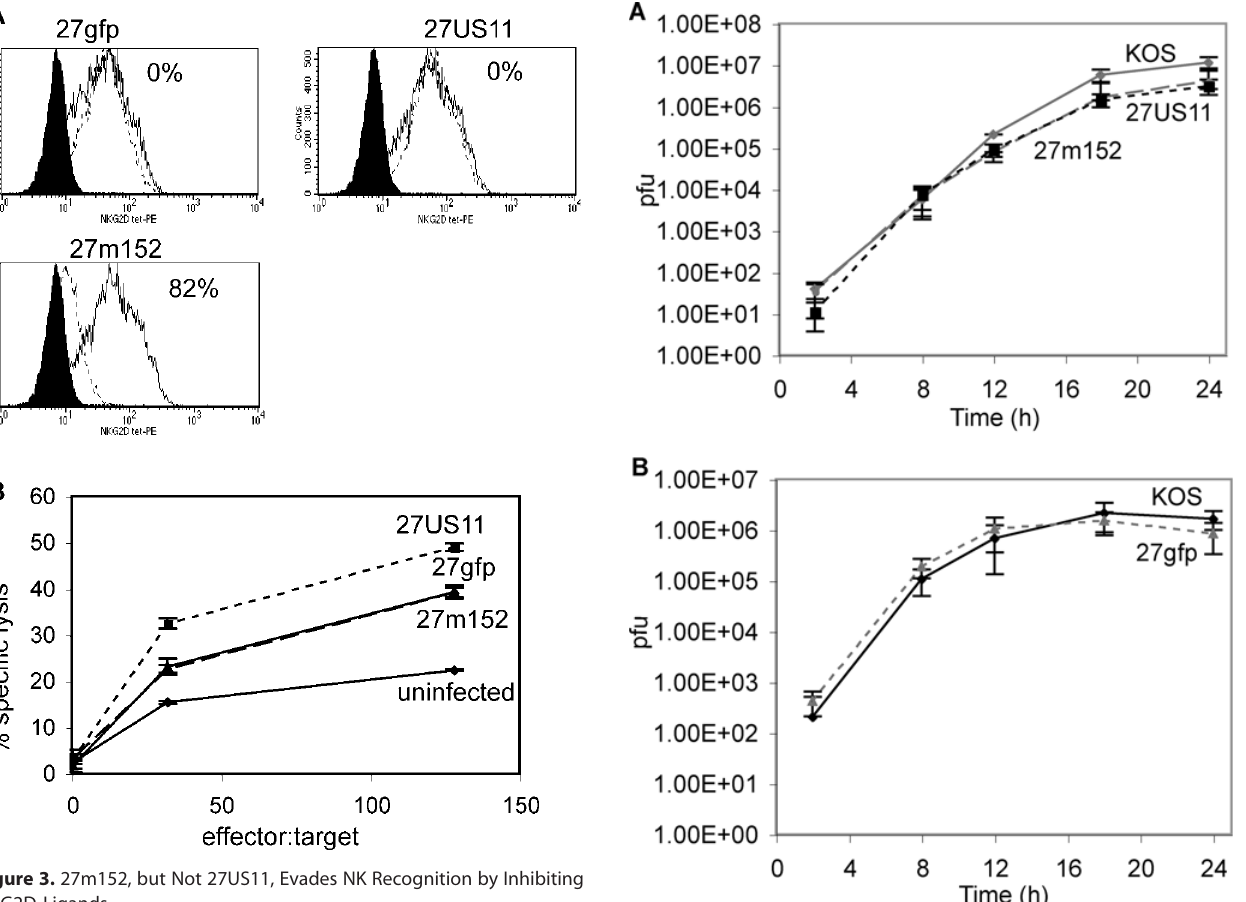
27m152 rHSV are attributable to MHC class I inhibition and evasion of CD8 T cells.